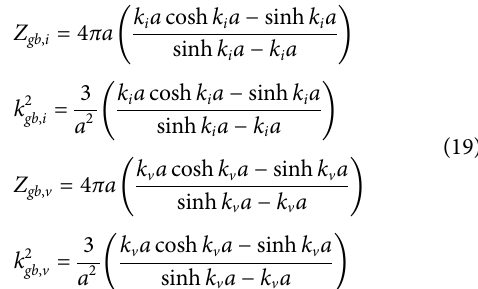
Frontiers in Materials |